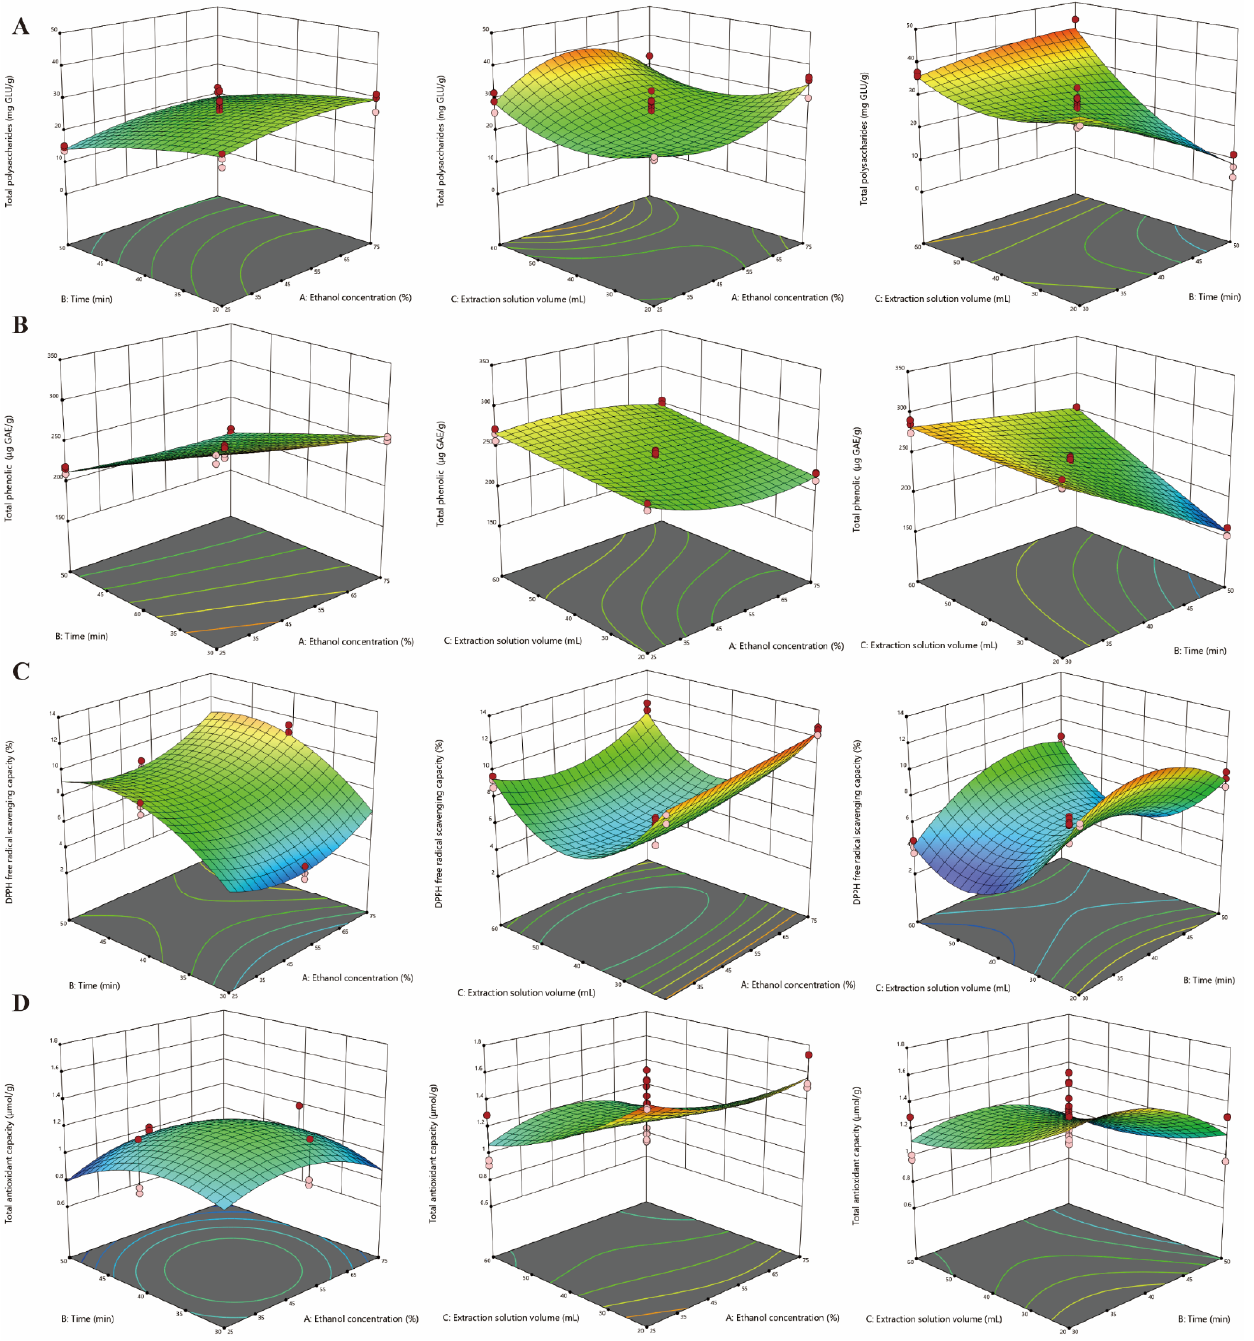
Figure 2. Response surface plots of ultrasound-assisted extraction conditions displaying the influ- ence of independent variables ( A ) total polysaccharides (TPs), ( B ) total phenolic (TPc), ( C ) DPPH free radical scavenging capacity (DPPH-SC), ( D ) total antioxidant capacity (T-AOC). radical scavenging capacity (DPPH-SC), ( D ) total antioxidant capacity